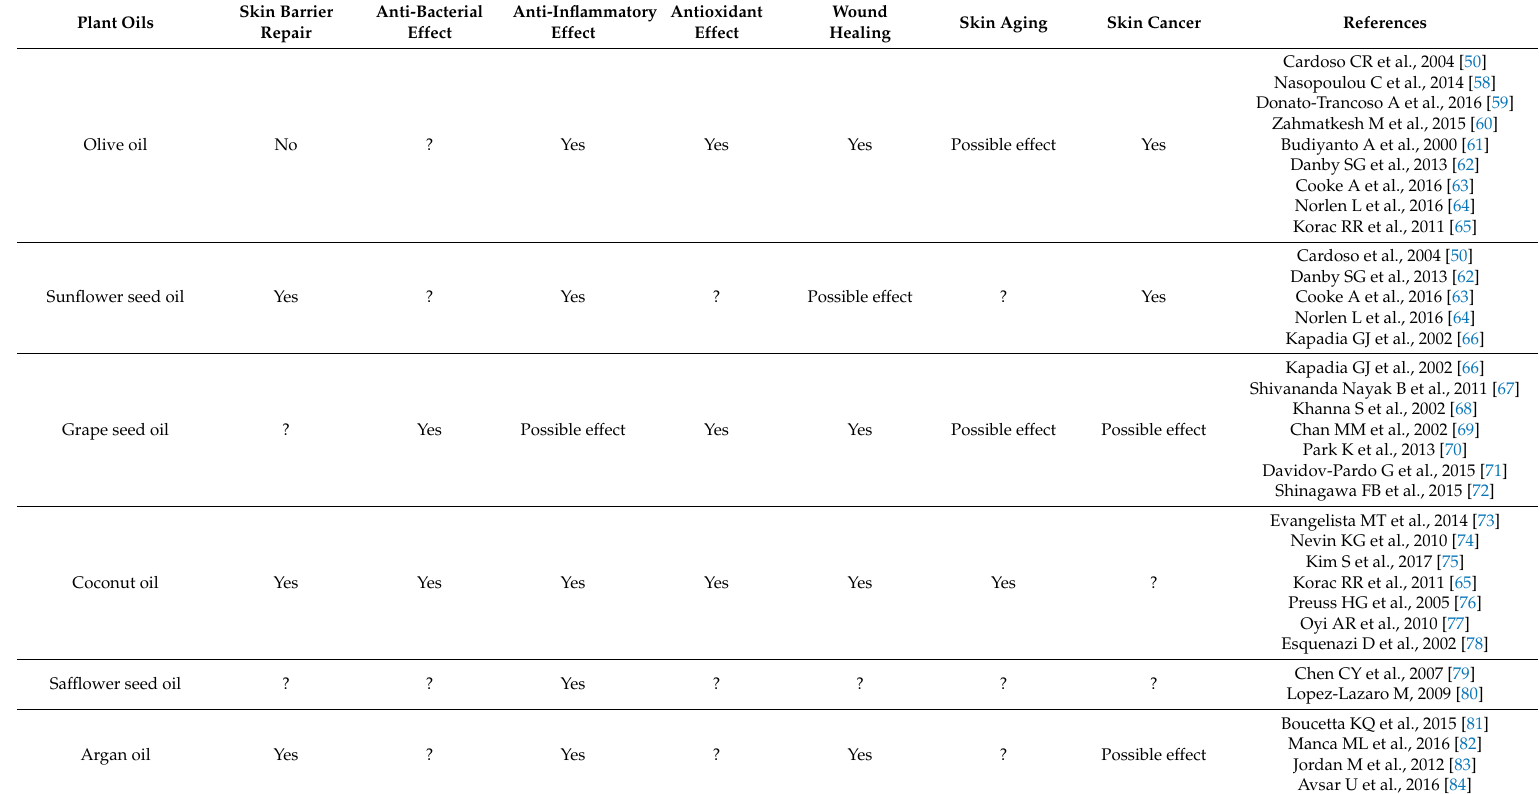
Table 1. The effects of topically applied plant oils on skin